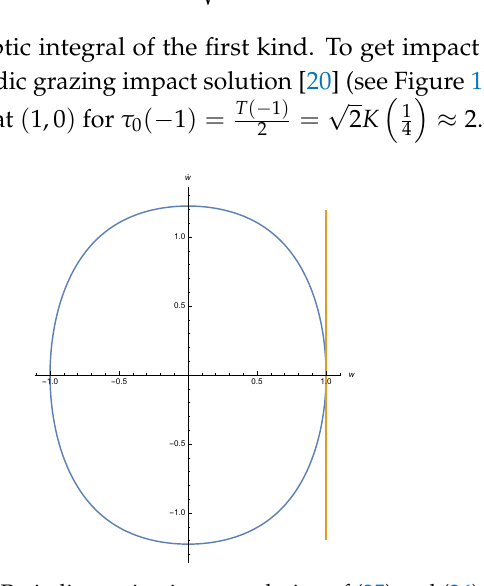
Figure 1. Periodic grazing impact solution of (25) and